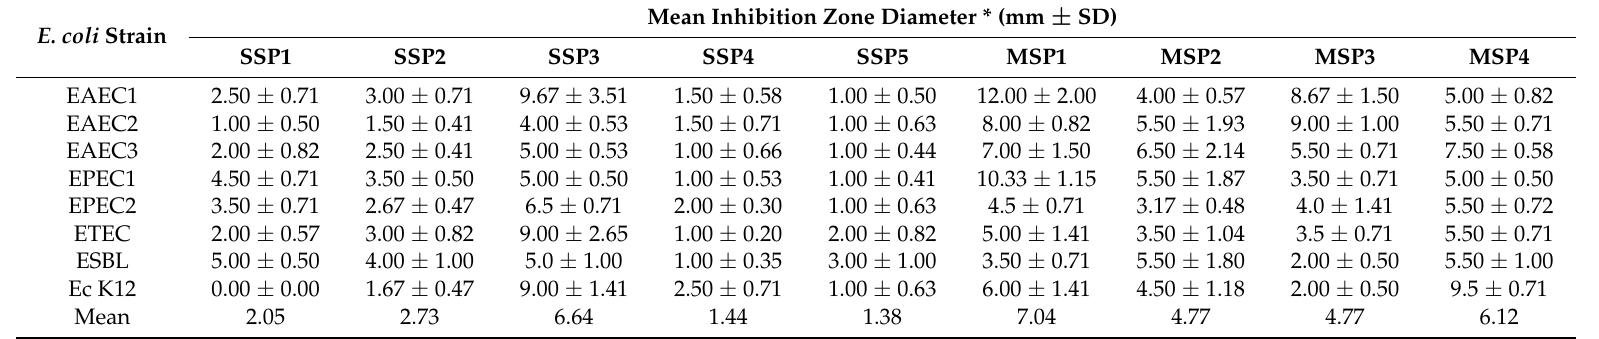
* mean of three separate trials in mm, measured from the outer edge of the colony to the edge of the clear zone.